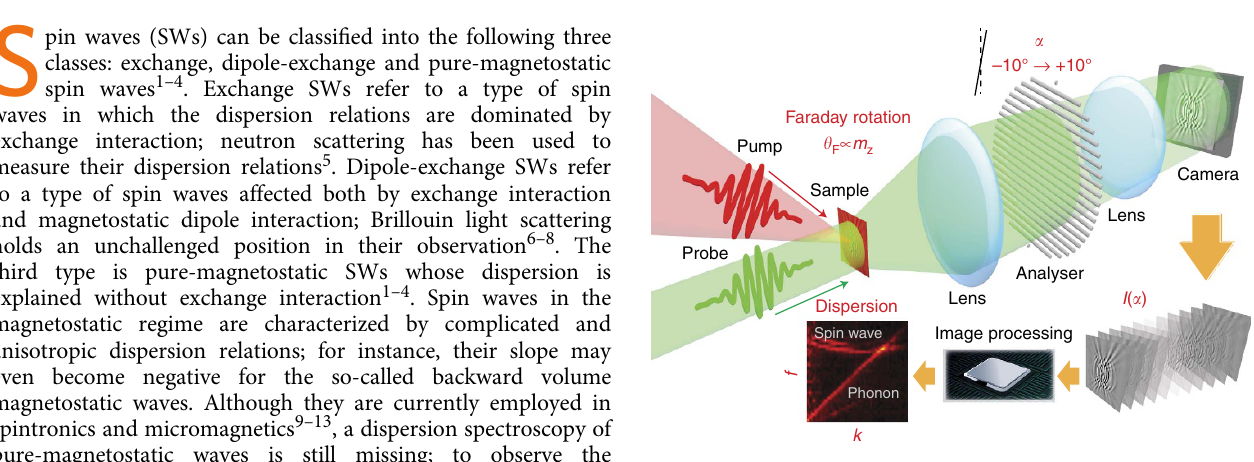
Figure 1 | Schematic illustration of spin wave tomography. Spin-wave tomography (SWaT) is based on the observation of the propagation dynamics of spin waves with the pump-and-probe magneto-optical imaging method. Various modes of spin waves are excited simultaneously by the illumination of the pump laser pulse in magnetic materials. The propagation dynamics of the spin waves are measured through the Faraday effect on the probe pulse ( y F ), which is proportional to the magnetization along the direction normal to the sample surface ( m z ). The images of y F are obtained by analyzing the transmission images ( I a ) observed at various angles of the analyzer ( a ) 26 . The spin-wave dispersion relations are reconstructed by Fourier transforming the propagating waveform of the spin